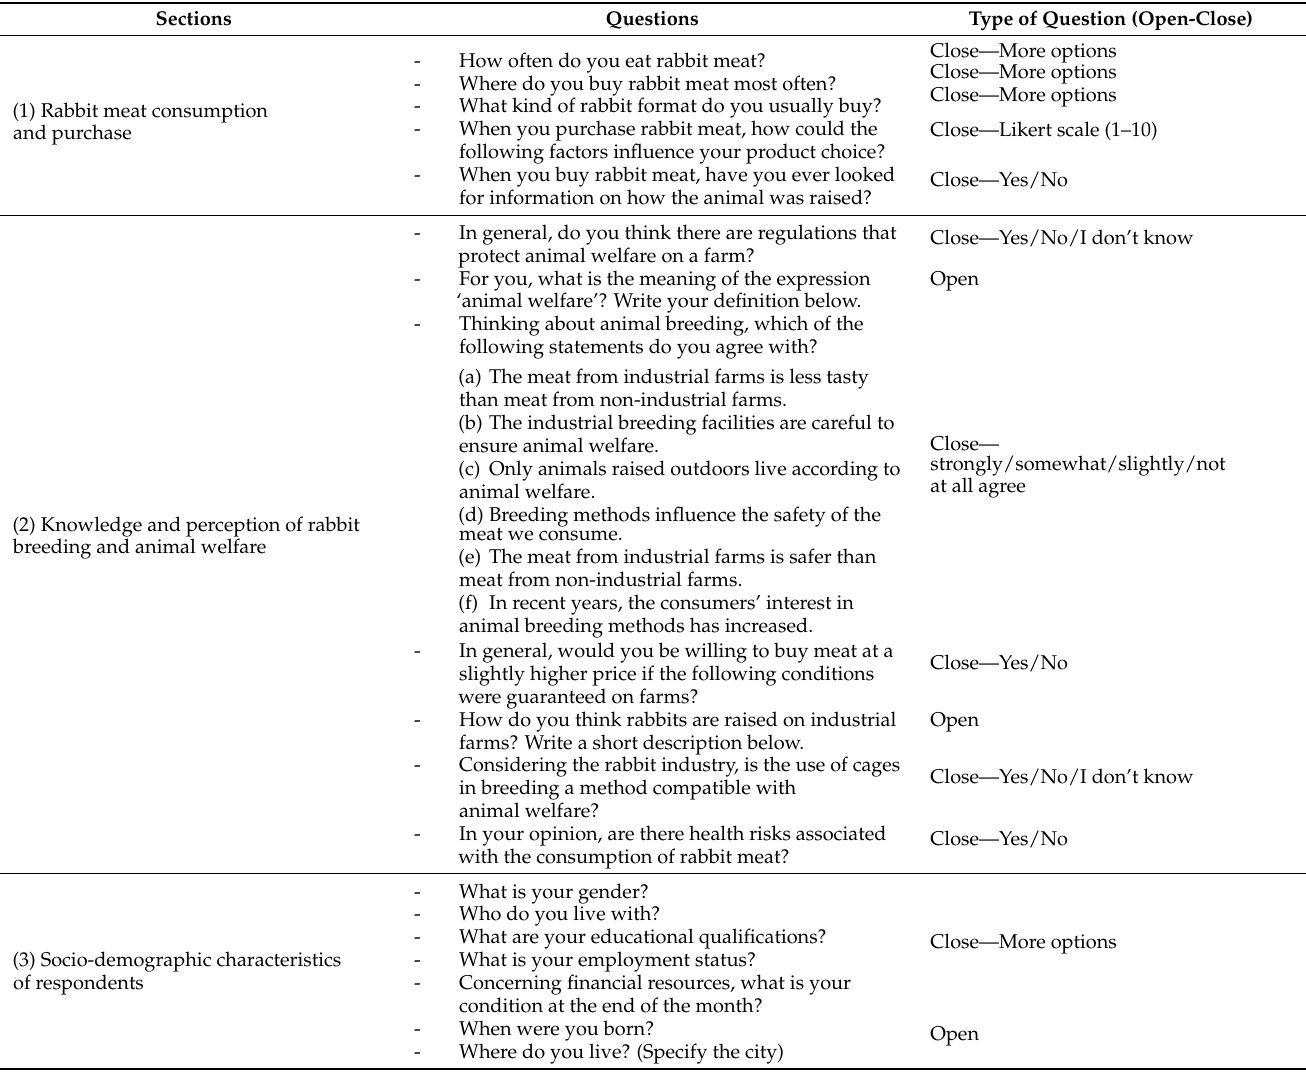
Table 1. Questions of the questionnaire were included in the